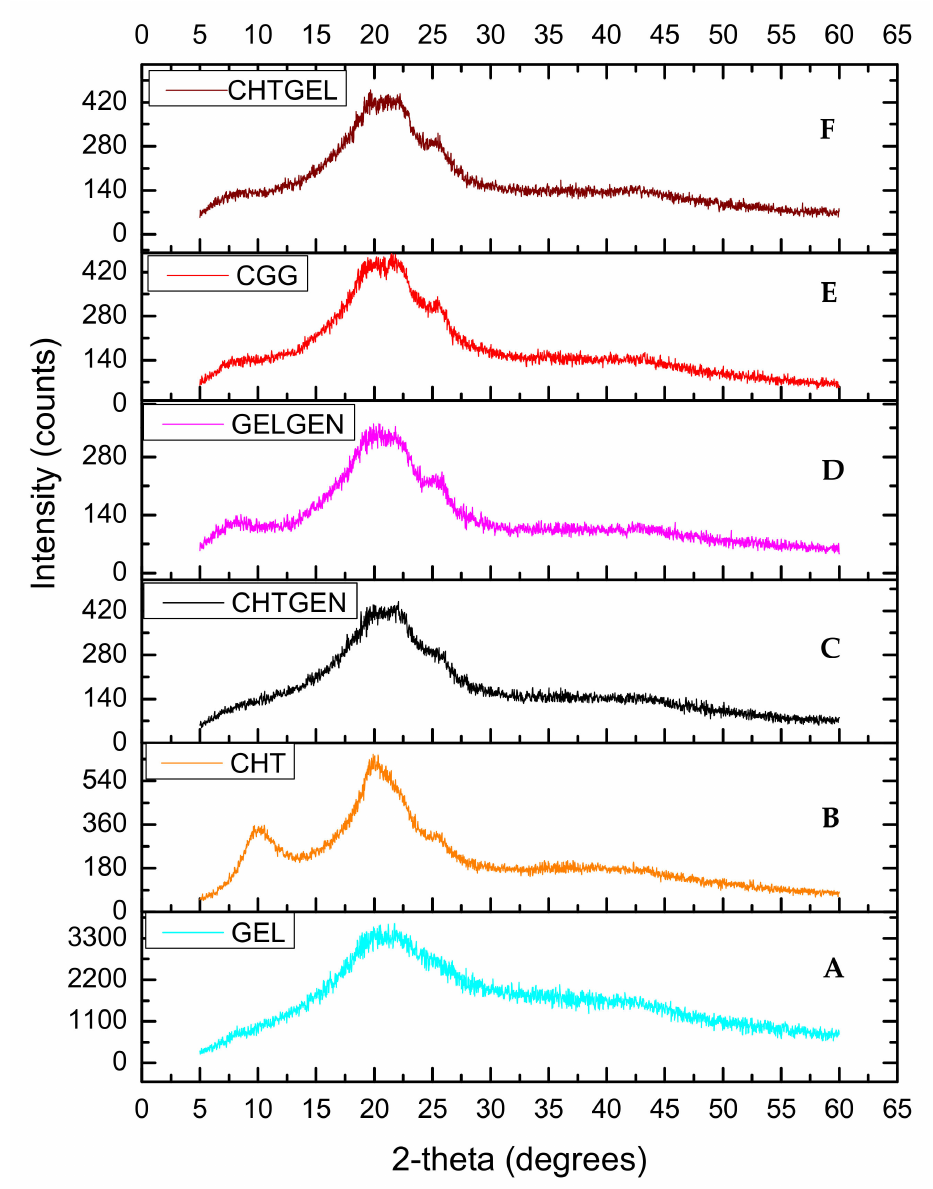
Figure 5. XRD of ( A ) chitosan, ( B ) gelatin, ( C ) CHTGEL, ( D ) CHTGEN, ( E ) GELGEN and ( F )